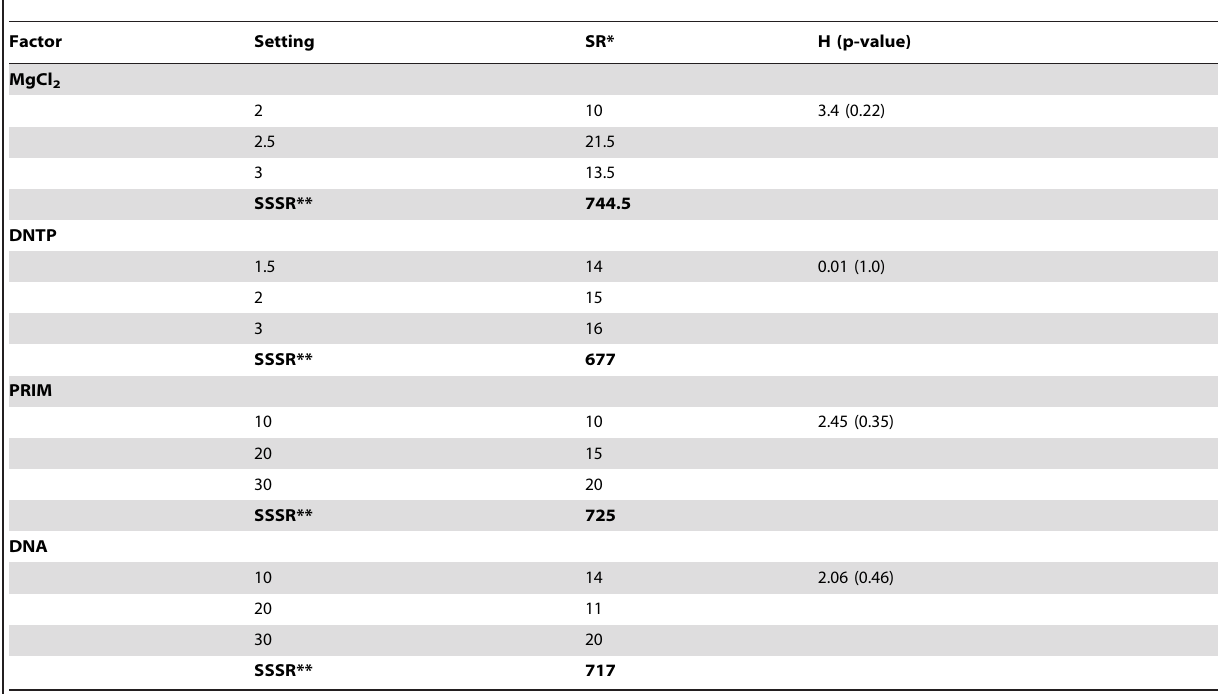
Table 7. Kruskal-Wallis statistics for the orderings in Table 6.